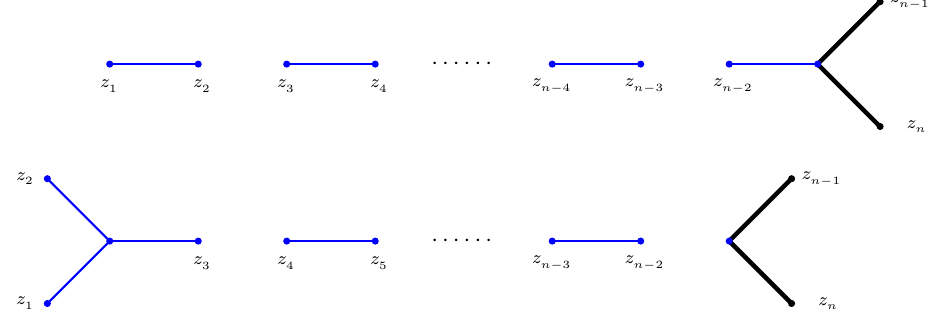
Figure 10 . Vacuum blocks with odd n . Figure 12 . Vacuum blocks with odd n . The bottom diagram corresponds to the disconnected Steiner tree (b) on (cid:12)gure 4. Figure 8 . Factorized 7-point block.